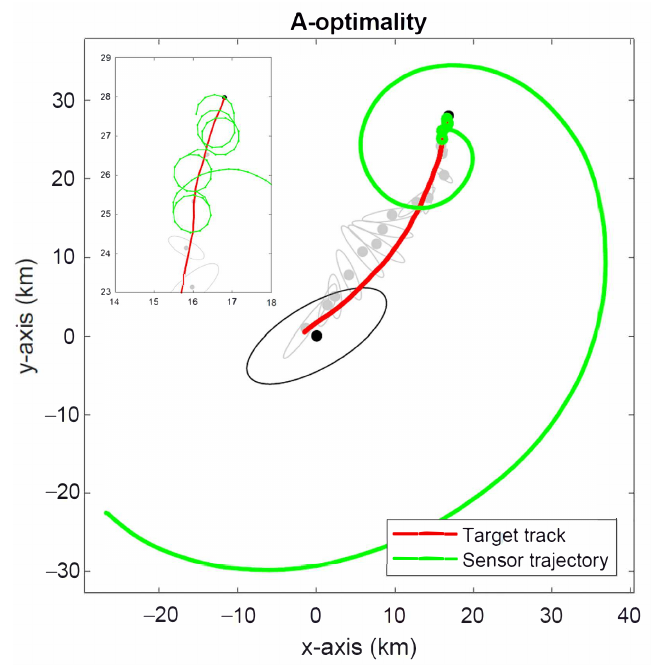
Figure 10. Optimal sensor trajectory for A-optimality